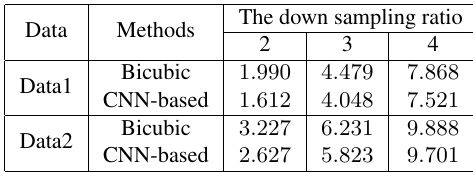
Figure 2. Down sampled DEM, bicubic and CNN